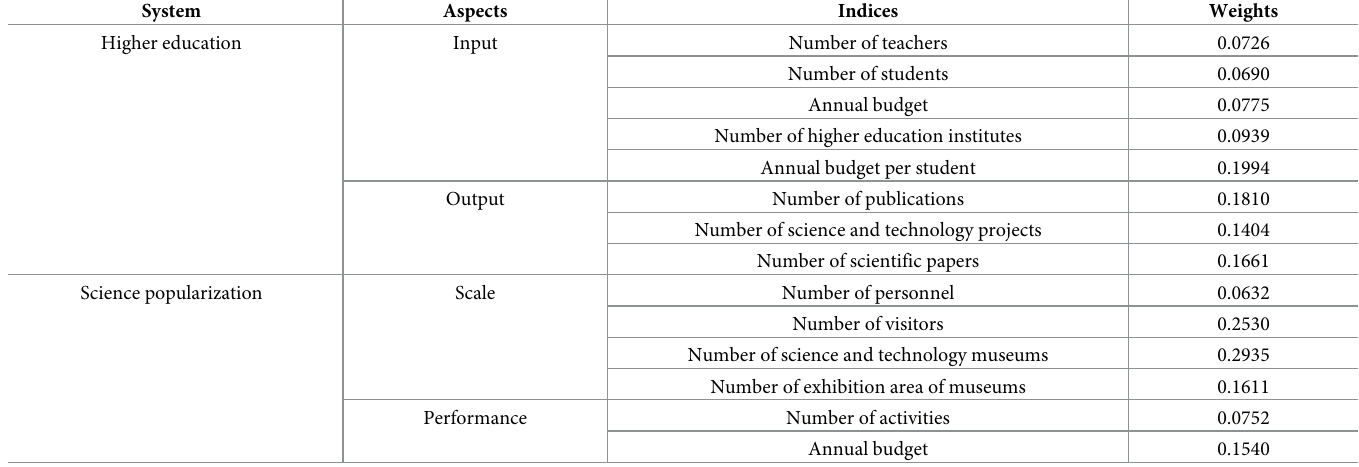
regions (Zhejiang, Hubei, and Sichuan), and they remained stable fluctuations within this grade for most years, demonstrating the average and unglamorous performances of these Table 5. Index